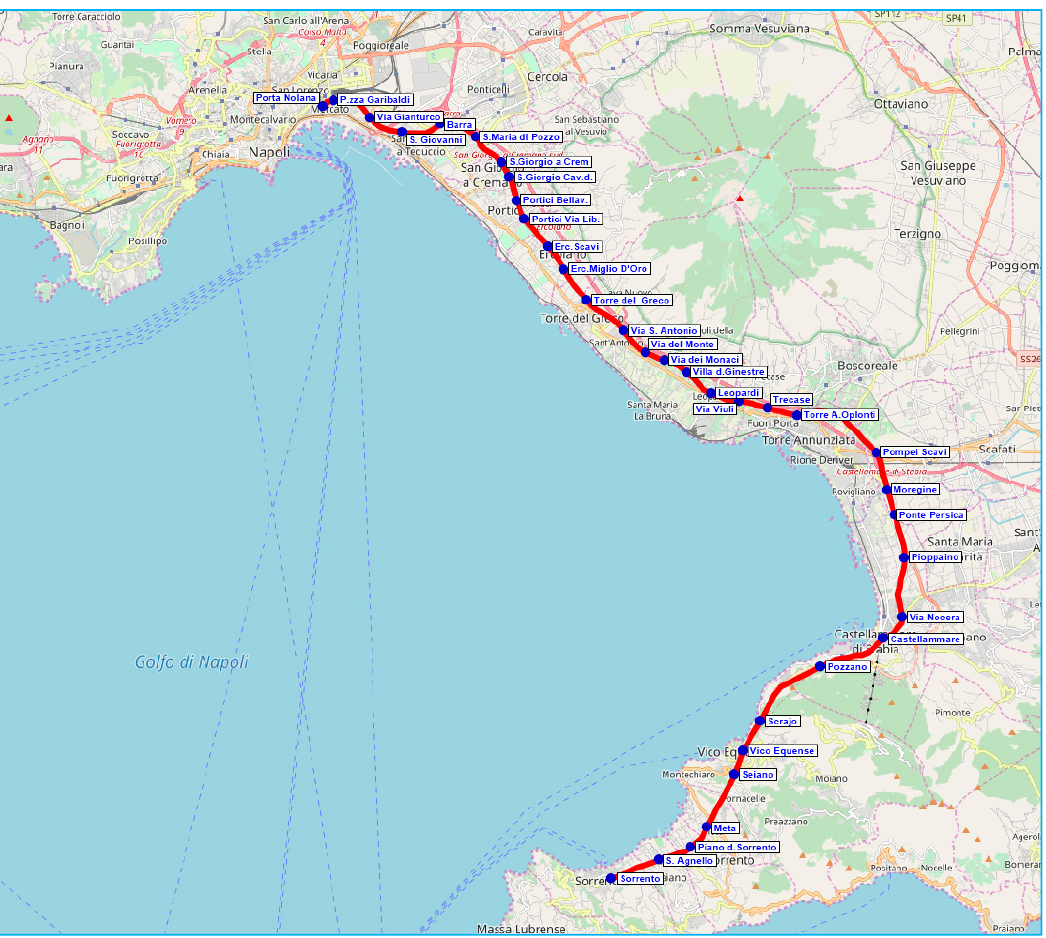
Figure 4. Regional ‘Naples–Sorrento’ rail line. Table 1. Main operational parameters of the regional ‘Naples-Sorrento’ rail